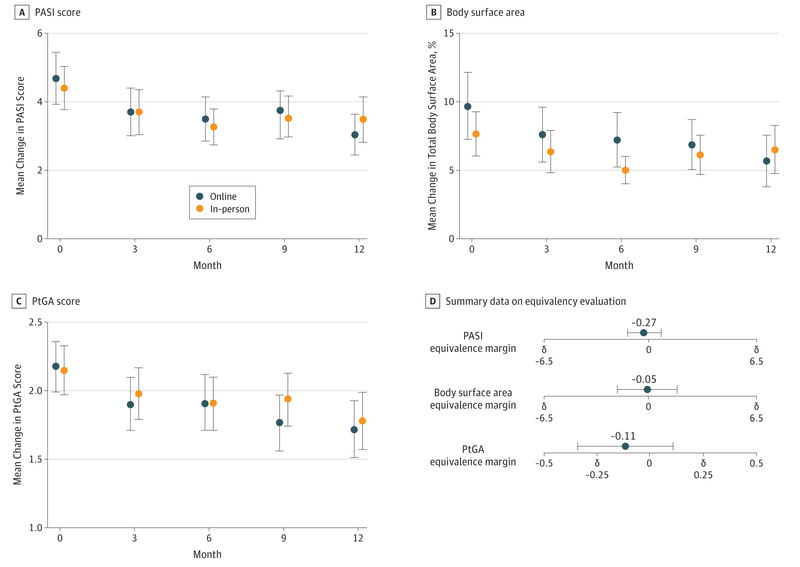
Changes in Psoriasis Disease Severity and Summary Data on Equivalency EvaluationA, Change in psoriasis disease severity as measured by Psoriasis Area and Severity Index (PASI) score by group over 12 months. B, Change in psoriasis disease severity as measured by body surface area by group over 12 months. C, Change in psoriasis disease severity as measured by Patient Global Assessment (PtGA) score by group over 12 months. D, Summary data on equivalency evaluation. Error bars indicate 95% CI.